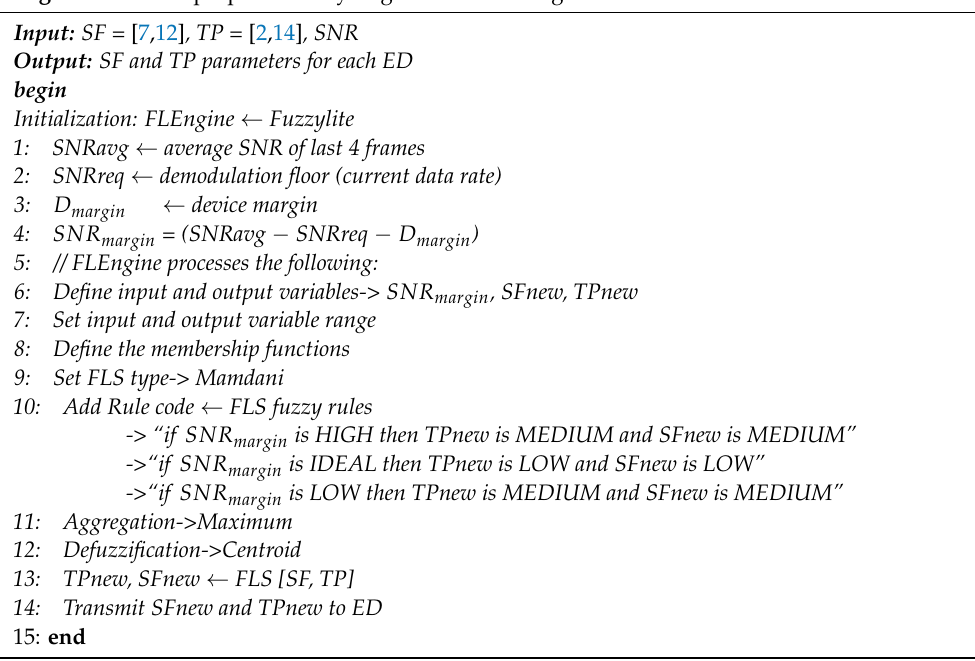
Algorithm 1: The proposed fuzzy- logic based ADR